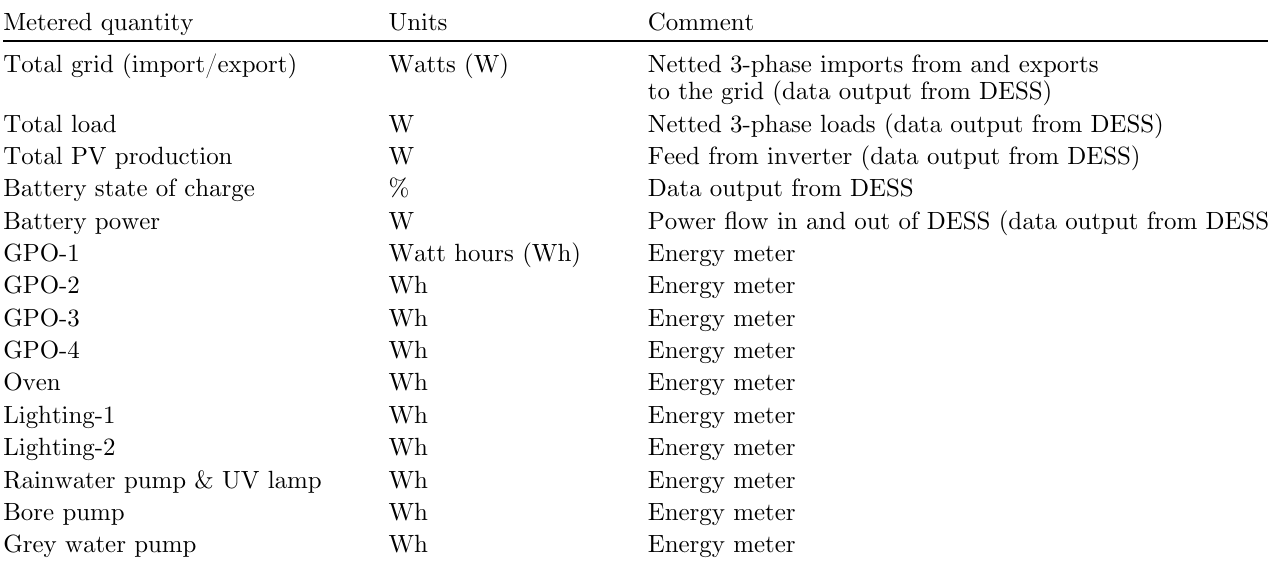
Table 1. Josh ’ s House monitoring system (electricity related metering